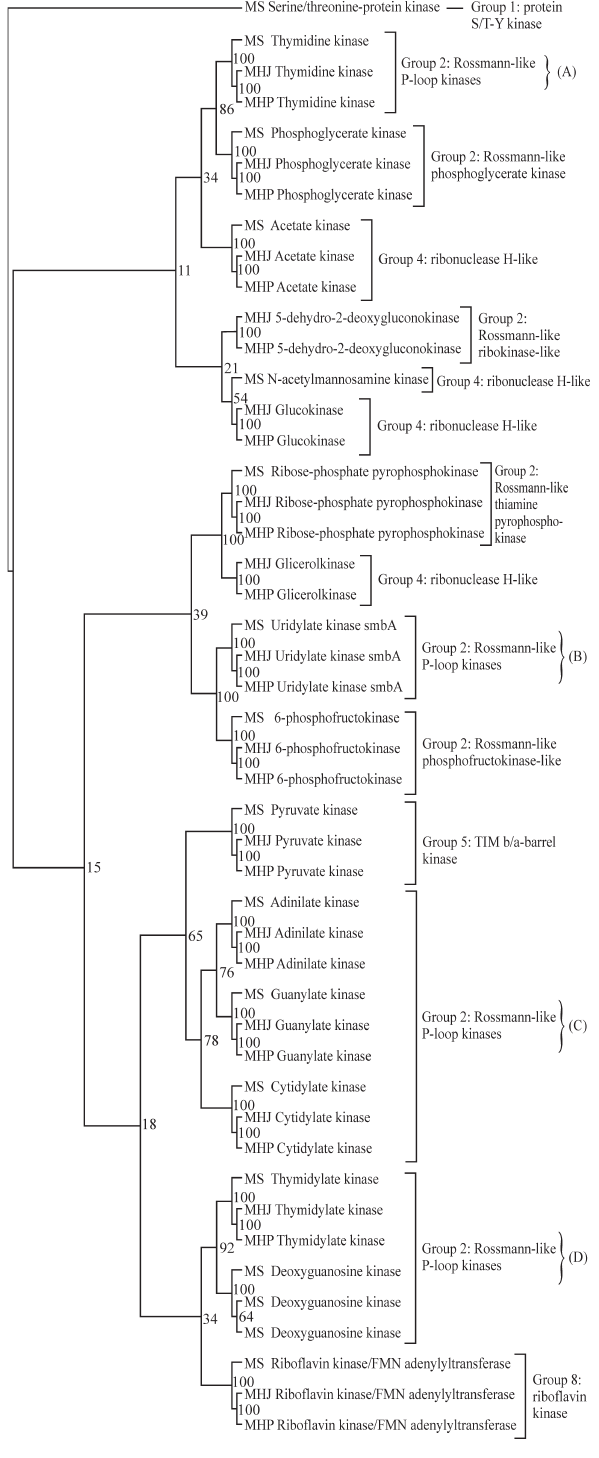
Figure 1 - Phylogenetic tree obtained from kinase amino acid sequence relationships. The kinase fold groups and families are shown in brackets on the right side. The Group 2: Rossmann-like P-loop kinases were clus- tered into four sub-groups (A, B, C and D). The numbers on the branches are bootstrap values obtained with 100 replications. The kinase encoding ORFs are represented by MSkinase ( M. synoviae ), MHJkinase ( M. hyopneumoniae J) and MHPkinase ( M. hyopneumoniae